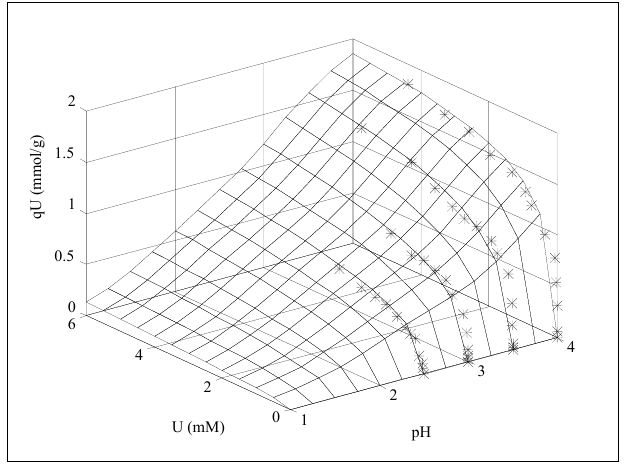
Fig. 10 . Fig 10: Uranium sorption isotherm experimental data and HIEM model regression at solution pH 2.5 – 4.0 and uranium concentration 0.0 – 6.0 mmol/L